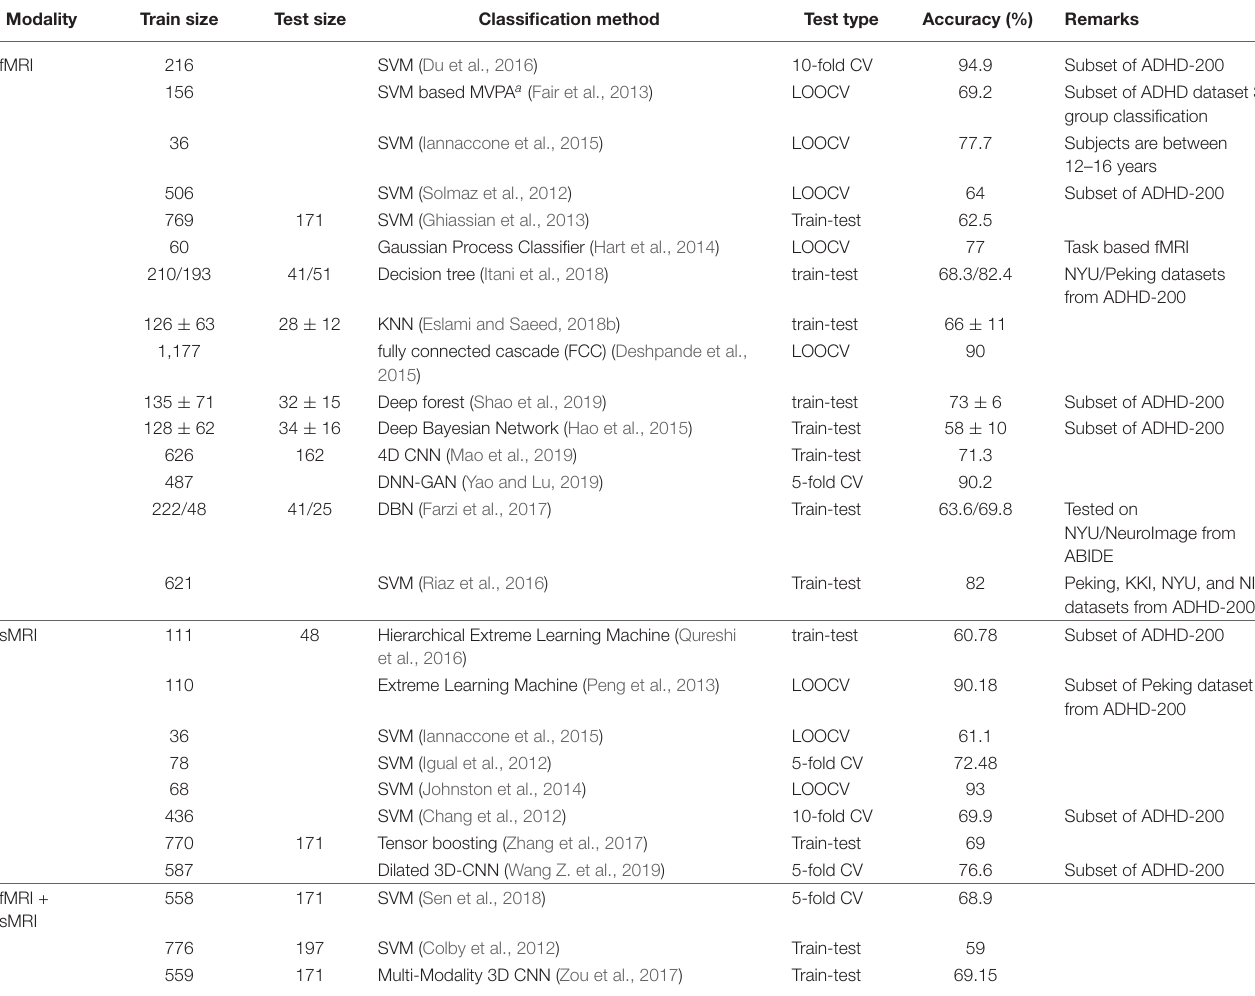
TABLE 2 | Literature review of ADHD diagnosis using ML and DL methods is shown.